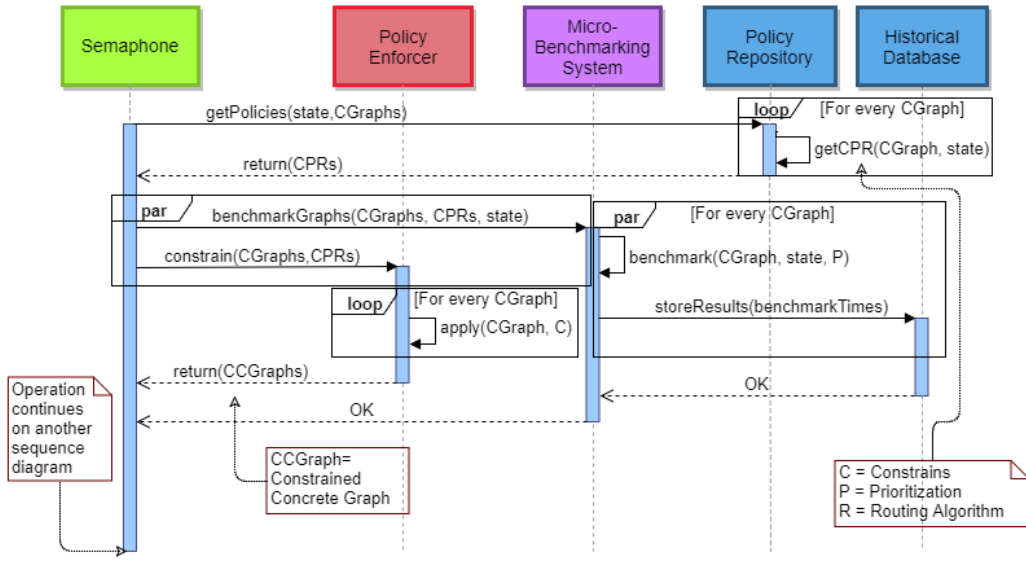
Figure 15. Constraints and